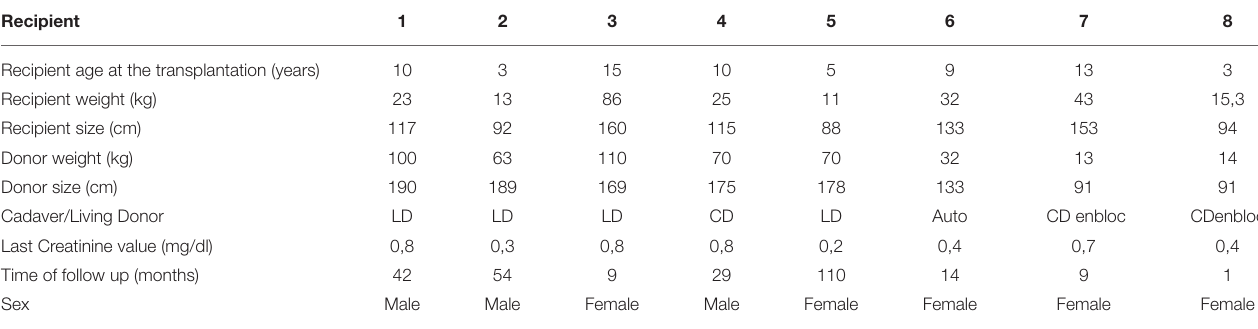
TABLE 1 | The characteristics of donors and recipients.